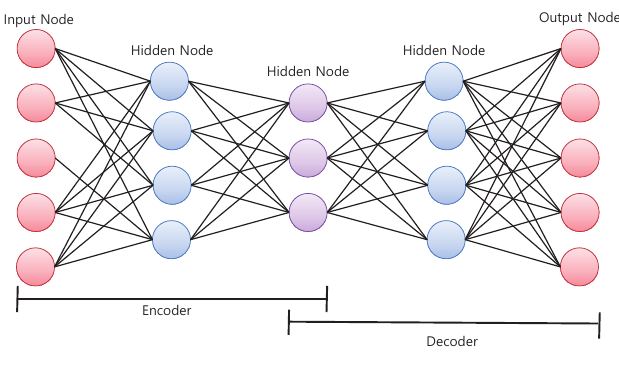
Figure 6. Structure of